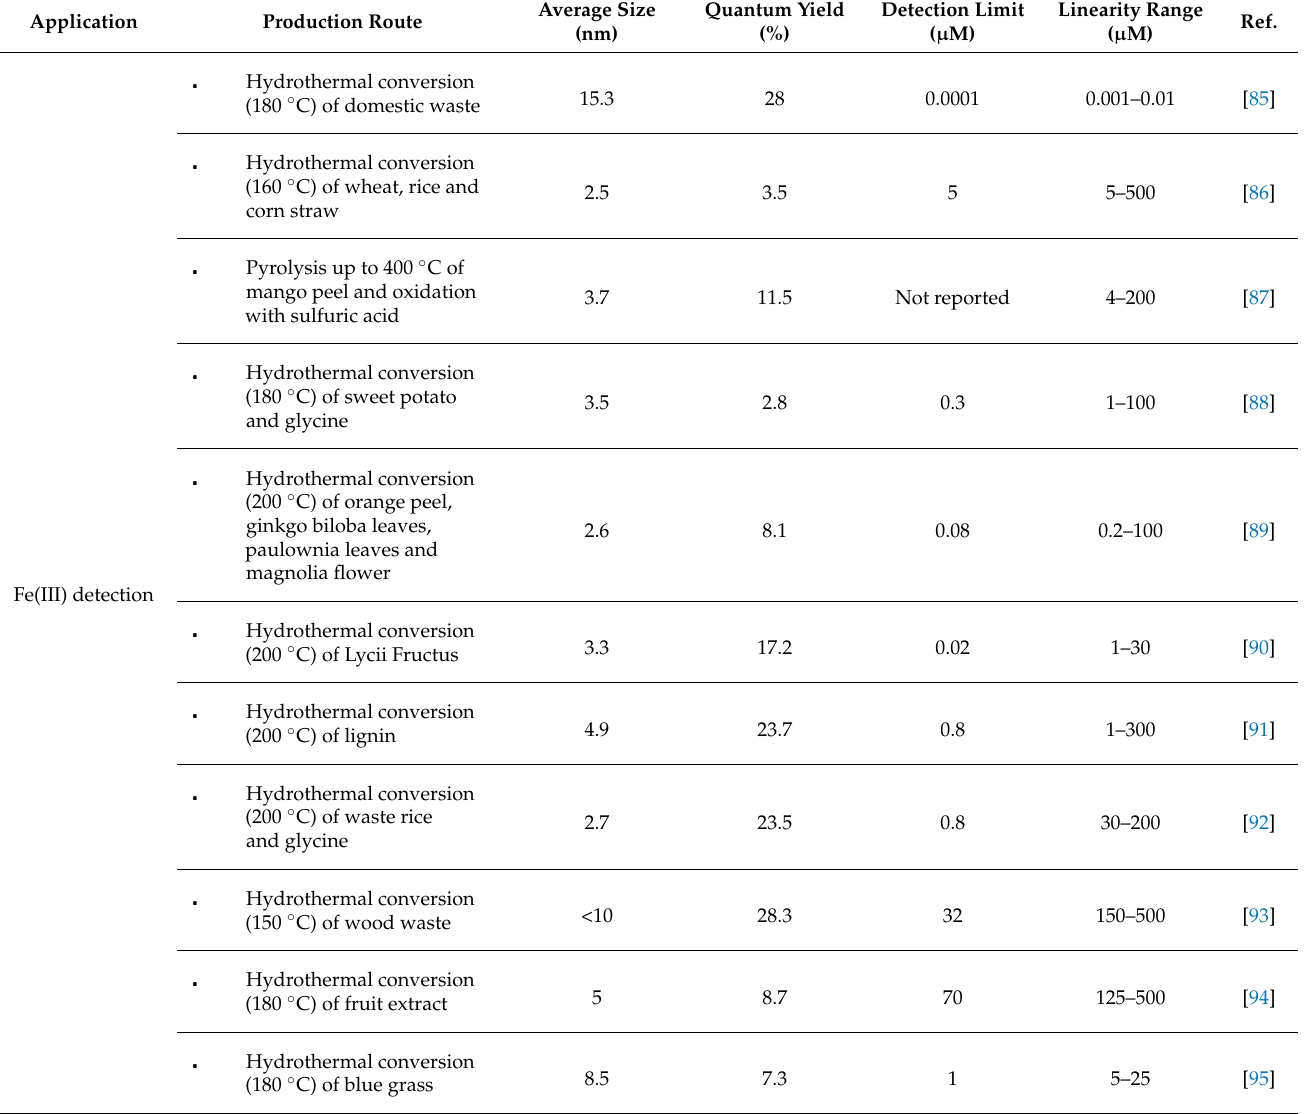
Table 1. Summary of the main study on inorganic ions in water phase detection by using BCCDs